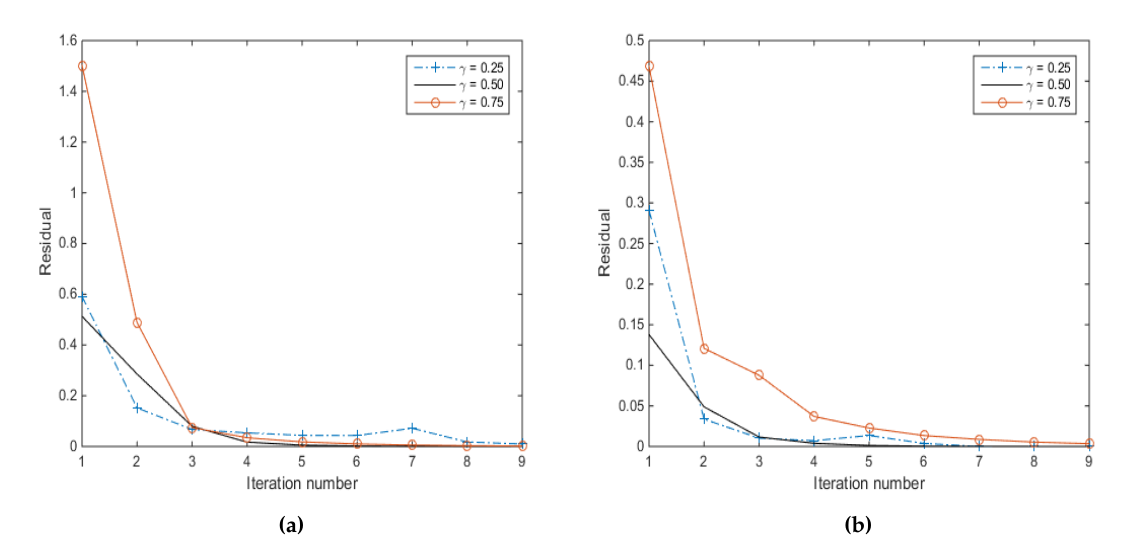
Figure 17. The residual for two source signals at DOAs 60 ◦ and 120 ◦ , with γ = 0.25,0.5 and 0.75, 10 iterations, SNR = − 5 dB using the MVDR A-LASSO algorithm, ( a ) 10 snapshots and ( b ) 50 snapshots. The twelfth simulation involves the investigation of the effect of varying the angular separation between the source signals. Consider two source signals, the first one held fixed at DOA of 60 ◦ , while the second one with DOA ranging from 61 ◦ to 100 ◦ with steps of 1 ◦ . The SNR is set to be 10 dB; 10 snapshots are considered for the simulation; 100 trials for each point; and a sampling grid ¯ θ ∈ [ 1 ◦ : 180 ◦ ] chosen to be of 0.1 ◦ steps. Figure 19 illustrates the DOA estimation error as a function n of the angular separation between the two source signals. It can be seen from this figure that the DOA estimation error is less than 2 ◦ for an angular separation < 5 ◦ . This DOA estimation error is reduced to < 0.4 ◦ for an angular separation ≥ 6 ◦